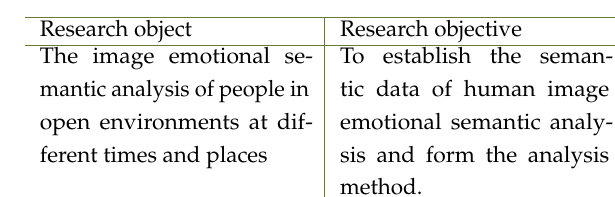
Table 1. The main research tasks of image